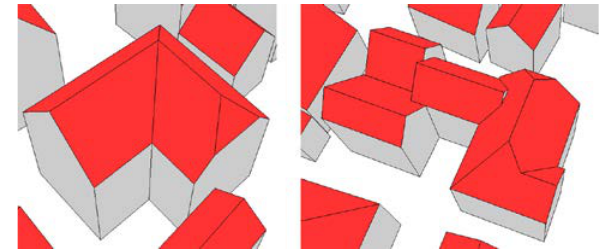
Figure 7. With global half-space adjustment reconstructed L-gable roof (left) and a more complex building (right).